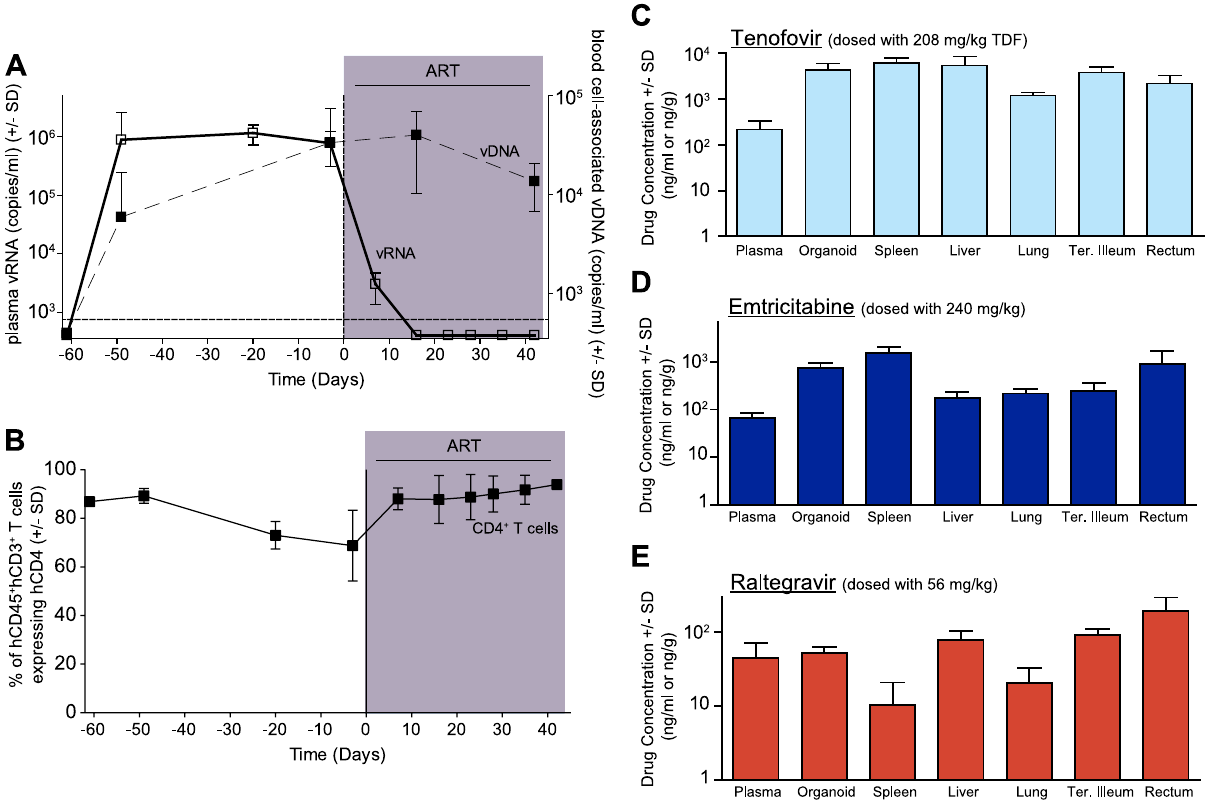
Figure 1. Efficacious plasma and tissue drug concentrations indicate broad dissemination of antiretrovirals during ART. ( A ) ART suppressed plasma viremia to below detection (vRNA; solid line, closed symbols) while peripheral blood cell-associated vDNA (dashed line; open symbols) were unaffected (Day 2 3 vs. Day42, p=0.63, signed rank test). ( B ) ART led to a rebound in peripheral blood CD4 + T cells to pre-infection levels. ( C–E ) Drug concentrations [tenofovir (C), emtricitabine (D) or raltegravir (E)] were determined within the plasma and each of the indicated tissues. For this steady state drug concentration analysis, the 4 BLT mice in (A) were harvested 21 hours following their last ART dosing and the tissue concentrations of the antiretrovirals were determined.